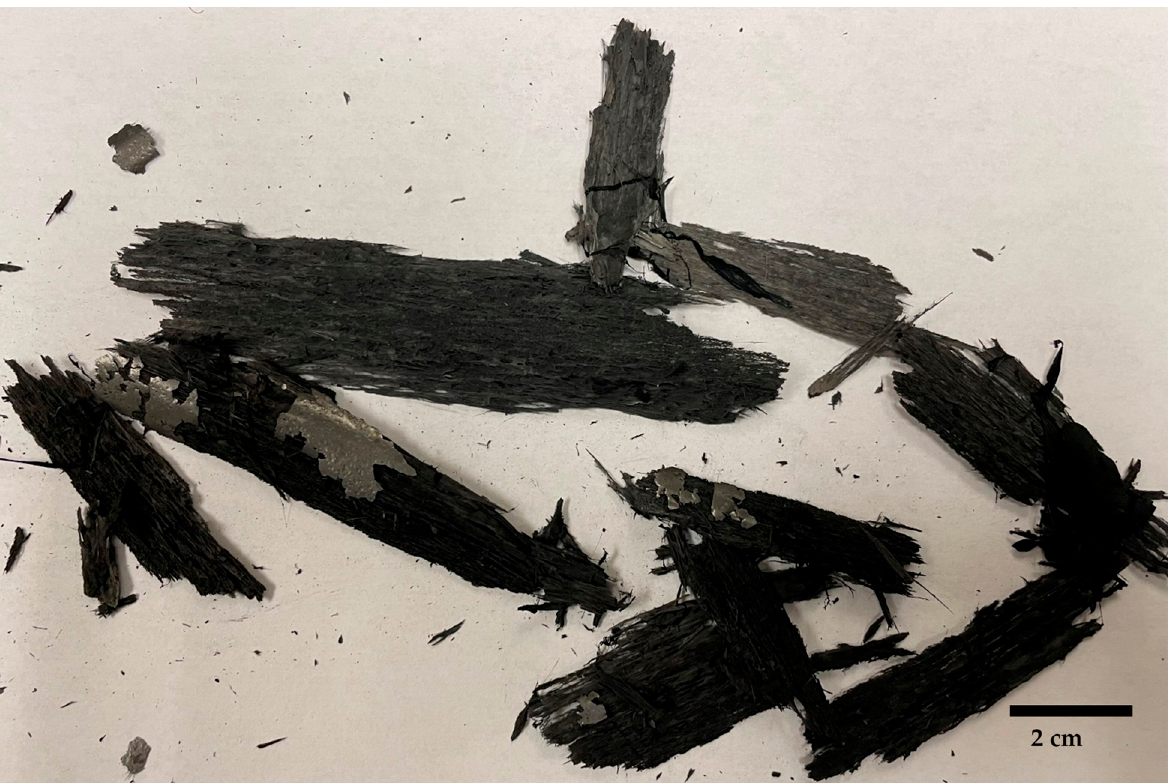
Figure 10. Deposits from the reactor tube after experiment.